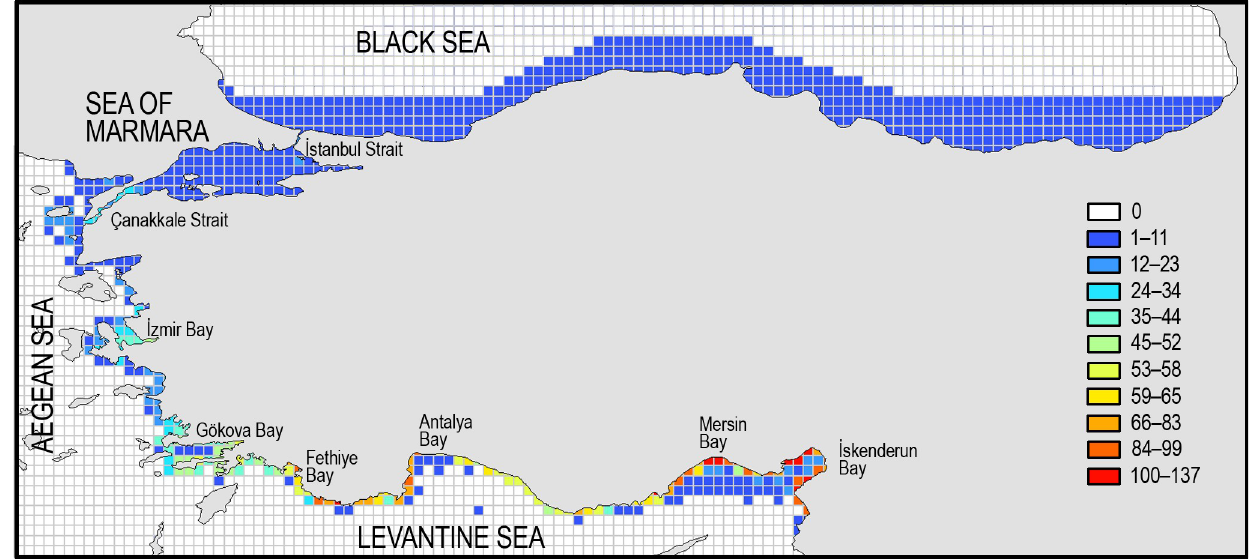
Fig 4. The number of alien species found in grids of 15x15 km along the coasts of Turkey.